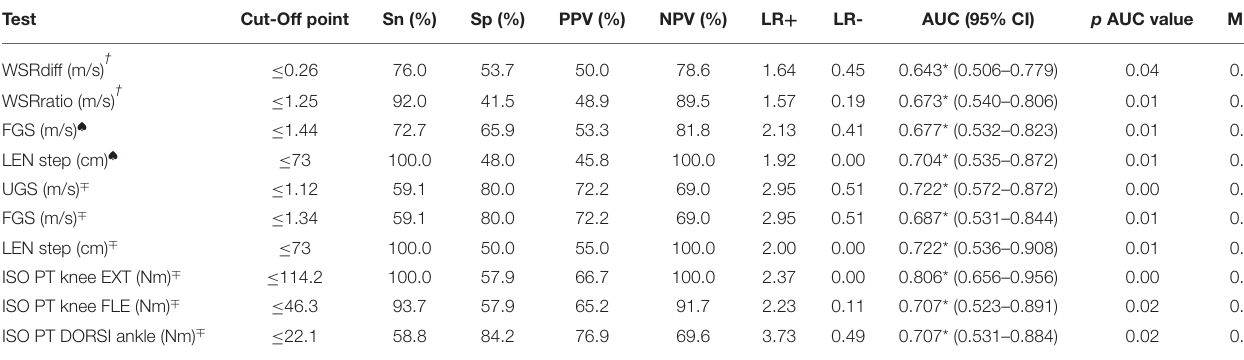
TABLE 5 | Predictive values for fall risk and recurrent falls, areas under the curve (receiver operating characteristic, ROC) and risk statistics. Test Cut-Off